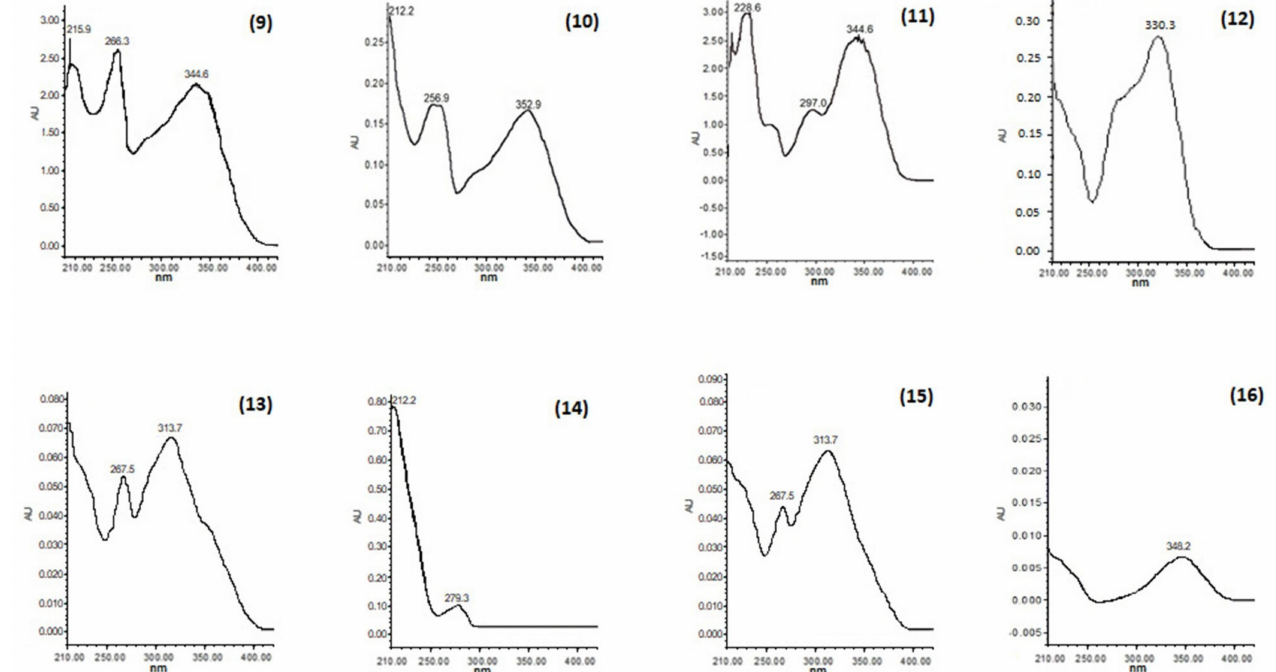
Figure 2. UV spectra of phenolic compounds (chlorogenic acid ( 1 ), coumaric acid ( 2 ), quercetin − 3 − O − rutinoside ( 3 ), caffeic acid ( 4 ), quercetin − 3 − O − glucoside ( 5 ), kaempferol − 3 − O − sophoroside ( 6 ), kaempferol − 3 − O − glucopyranoside ( 7 ), kaempferol − 3 − O − sambubioside ( 8 ), luteolin − 7 − O − glucoside( 9 ), quercetin − 3 − O − rhamnoside ( 10 ), scopoletin ( 11 ), rosmarinic acid ( 12 ), tiliroside ( 13 ), coumaric acid derivative ( 14 ), kaempferol 3 − O − (3 (cid:48)(cid:48) ,4 (cid:48)(cid:48) − Diacetyl − 2 (cid:48)(cid:48) ,6 (cid:48)(cid:48) − di − E − p − coumaroyl) − glucopyranoside ( 15